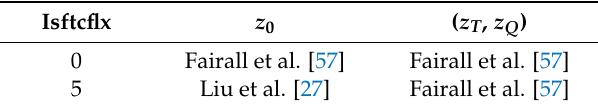
Table 1. The default isftcflx parameterization (0) and the additional parameterization option (isftcflx = 5) included in order to take into account wave state and sea spray effects. Isftcflx z 0 ( z T , z Q )